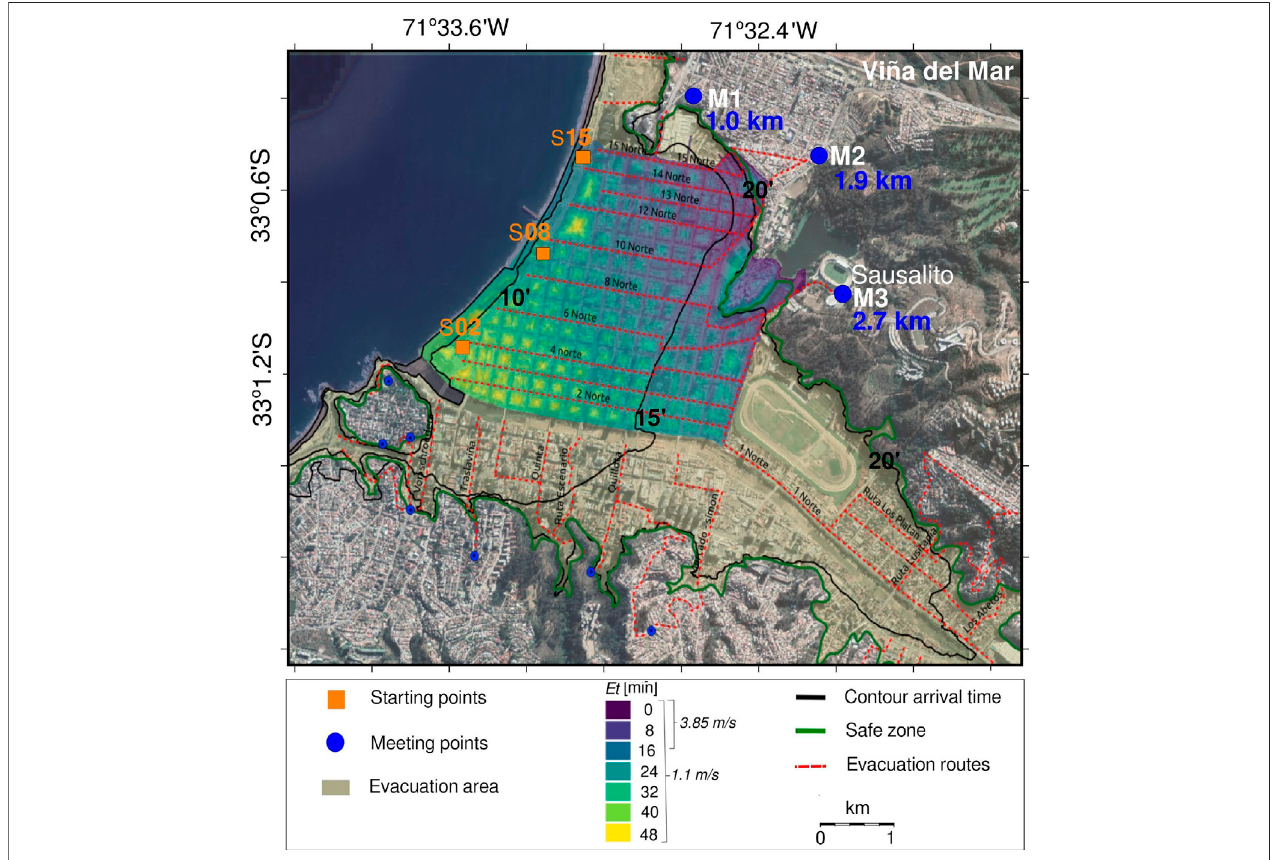
FIGURE 7 | Map comparing evacuation times (shown with the colored grid) and distances to tsunami arrival times for Viña del Mar. Black contours represent tsunamiarrival time isolines. Orange squares show three examplestarting points (S02, S08, S15)for persons tobe evacuated, for estimating their distancestothethree corresponding meeting points M1, M2 and M3; Et: pedestrian evacuation times according to the shortest routes from León et al. (2019b). Evacuation route (red) locations have been retrieved from: https://www.onemi.gov.cl/mapas/region/valparaiso/.